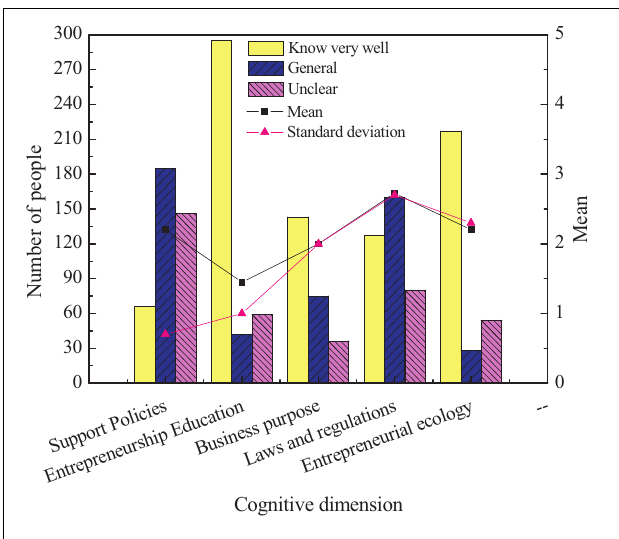
FIGURE 3 | Students’ entrepreneurial cognition of intangible cultural heritage.